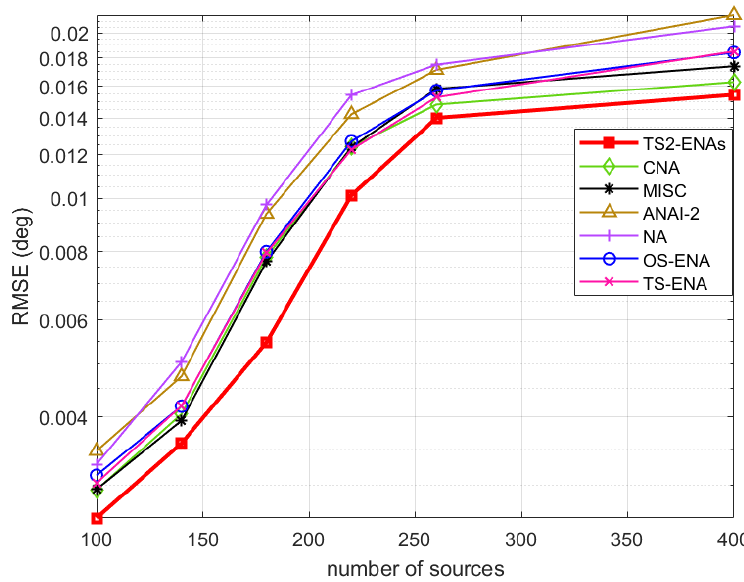
Figure 11. RMSE vs. number of